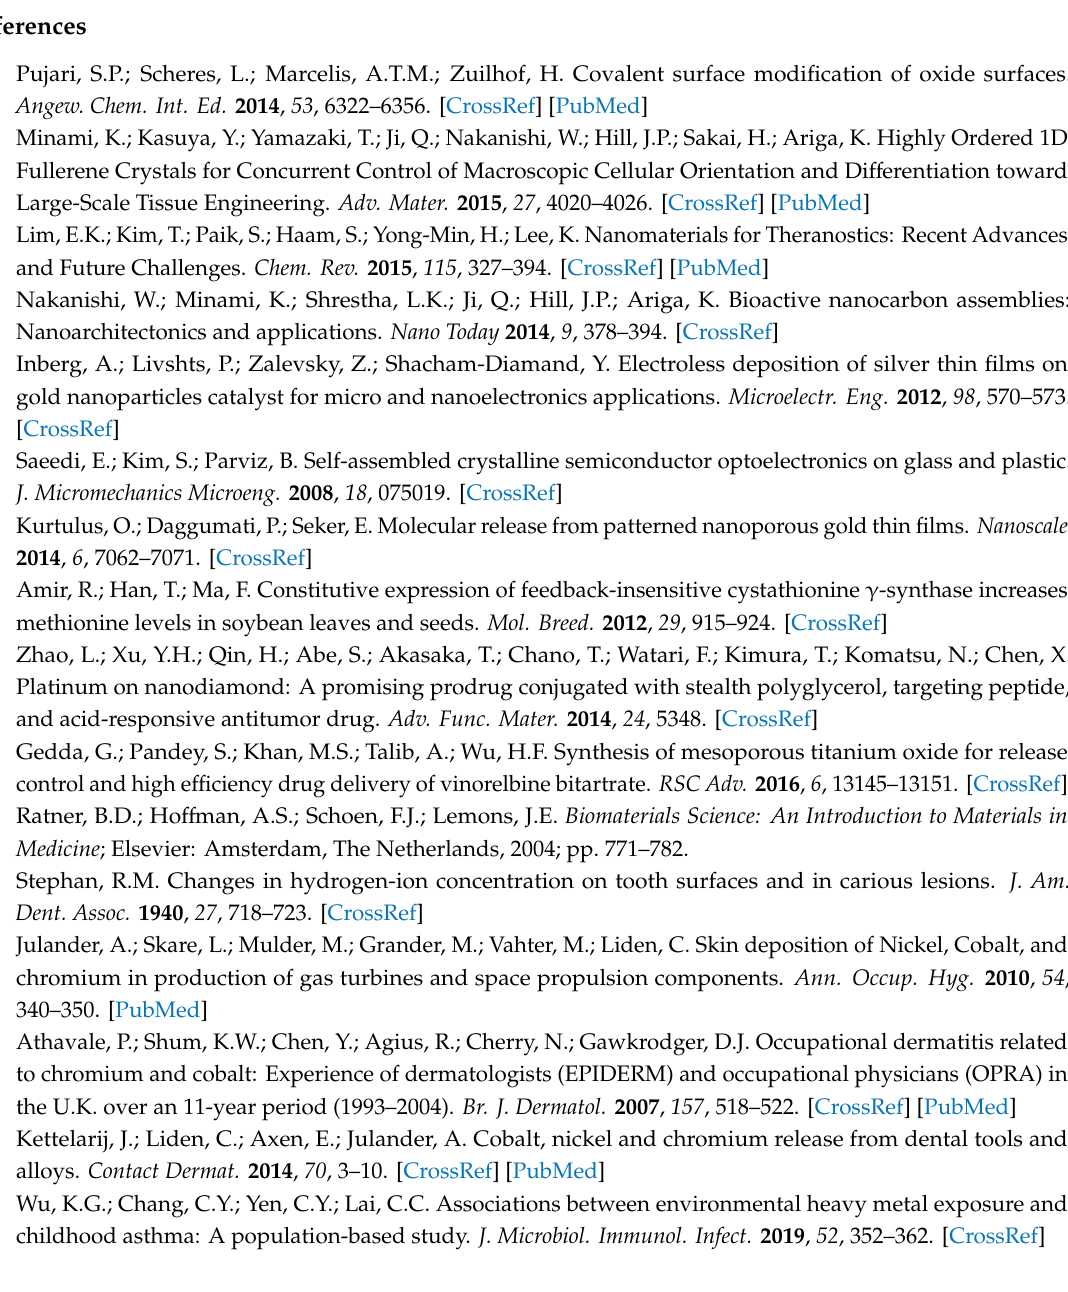
Figure S1: Raman spectra showing the eluted metal ion polyamine-tethered reaction on the stainless steel surface, (a) before and (b) after the reaction. Figure S2: A typical SEM image of a dental orthodontic stainless steel wire surface (0.2 M HCl for one